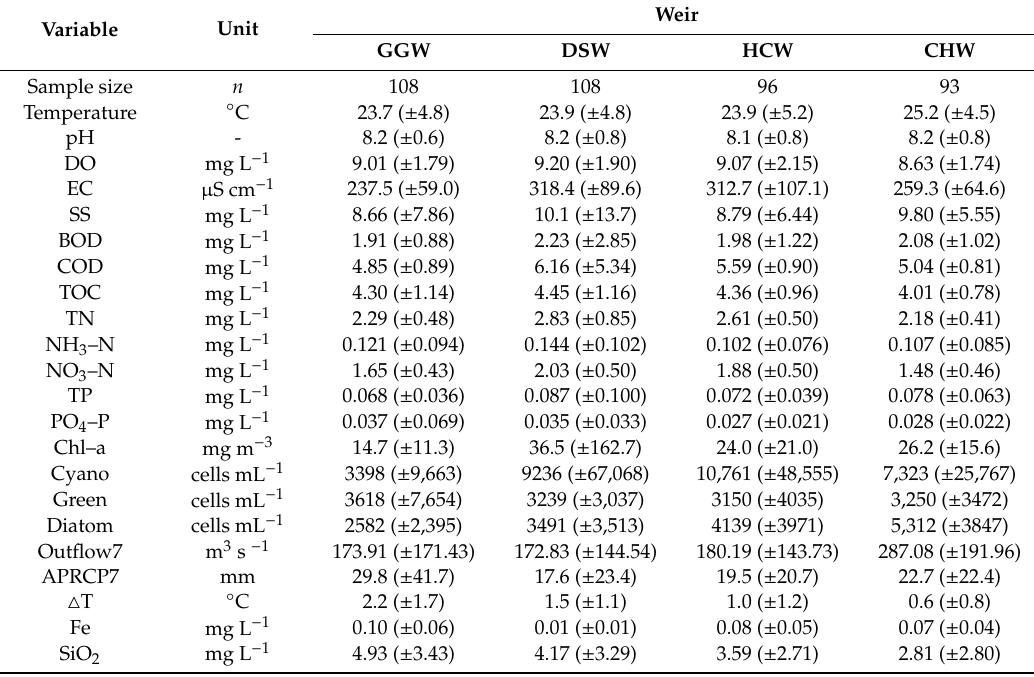
Table 1. Mean values ( ± standard deviation) of water quality data from the Gangjeong Goryeong weir (GGW), Dalseong weir (DSW), Hapcheon Changnyeong weir (HCW), and Changnyeong Haman weir (CHW). Note: see the main text for definitions of